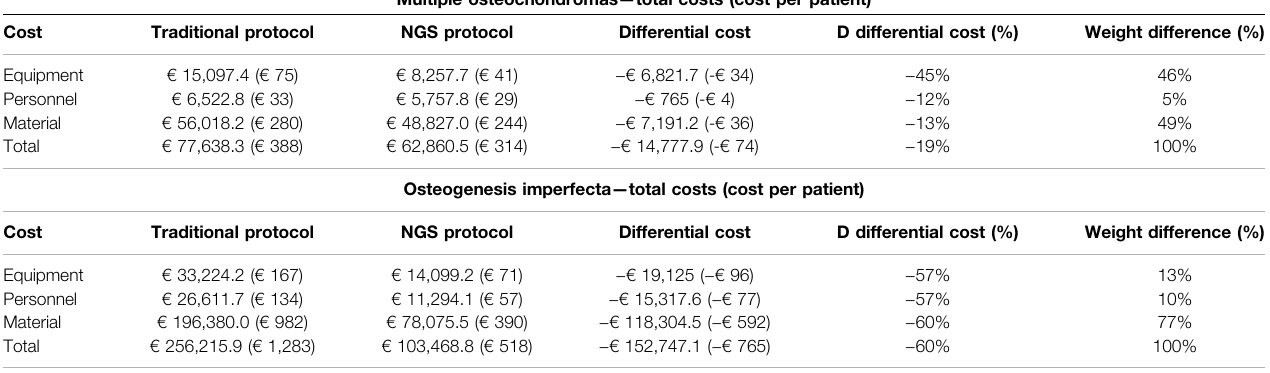
TABLE 3 | Cost analysis, single-gene protocol versus NGS